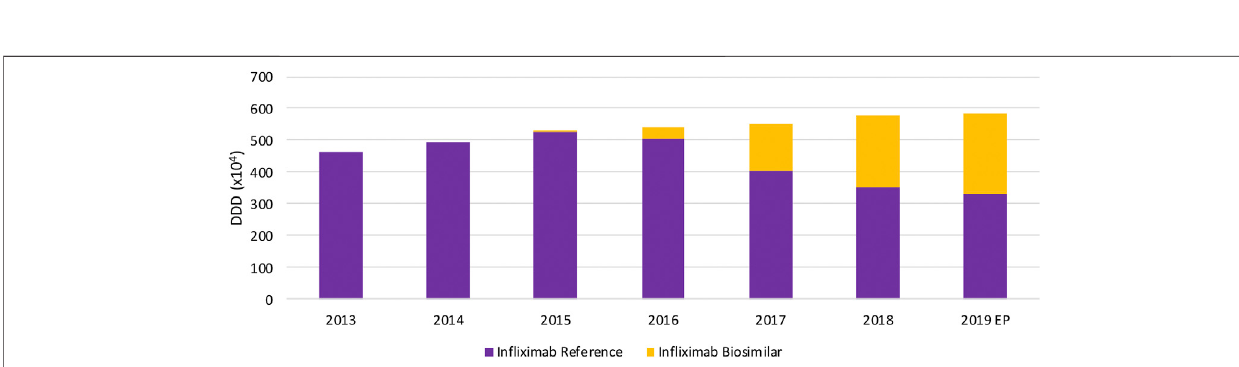
Frontiers in Pharmacology |